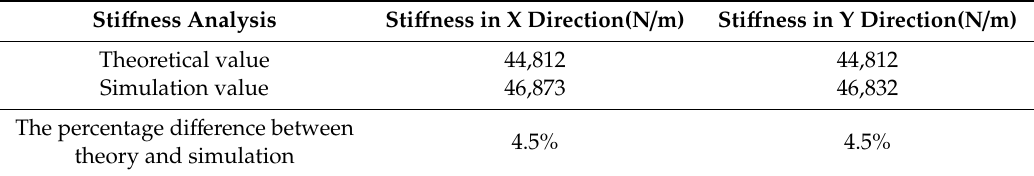
Table 3. Comparison of theoretical value and simulation value of micro-positioning platform stiffness.